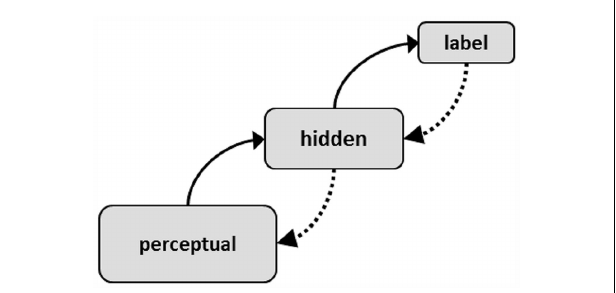
FIGURE 1 |A schematic of a neural network architecture for exploring on-line effects of labels on perceptual representations. See text for